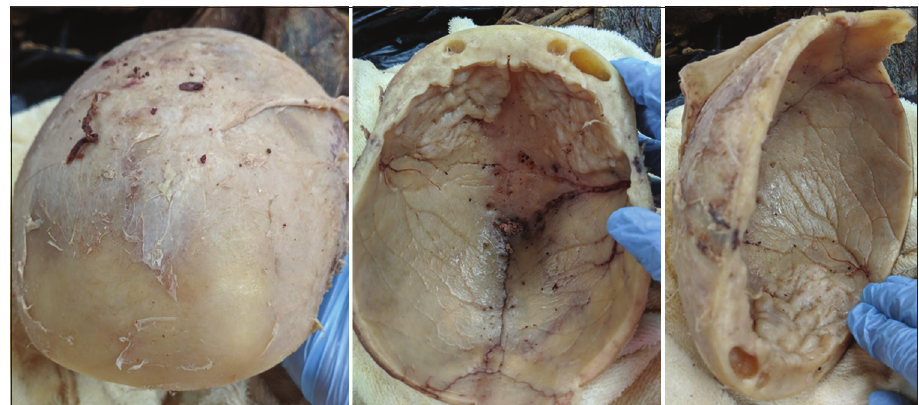
FIGURE 1. Images of the cadaver from left to right: Superior view of the external calvarium, notably without external abnormalities. Inferior view of the calvarium with a clear lambdoid suture posteriorly, and thickened, bubbled frontal bone, and porous cavities are seen in the cutaway. Right-sided view showing the thickness of the frontal bone compared to the much thinner adjacent parietal